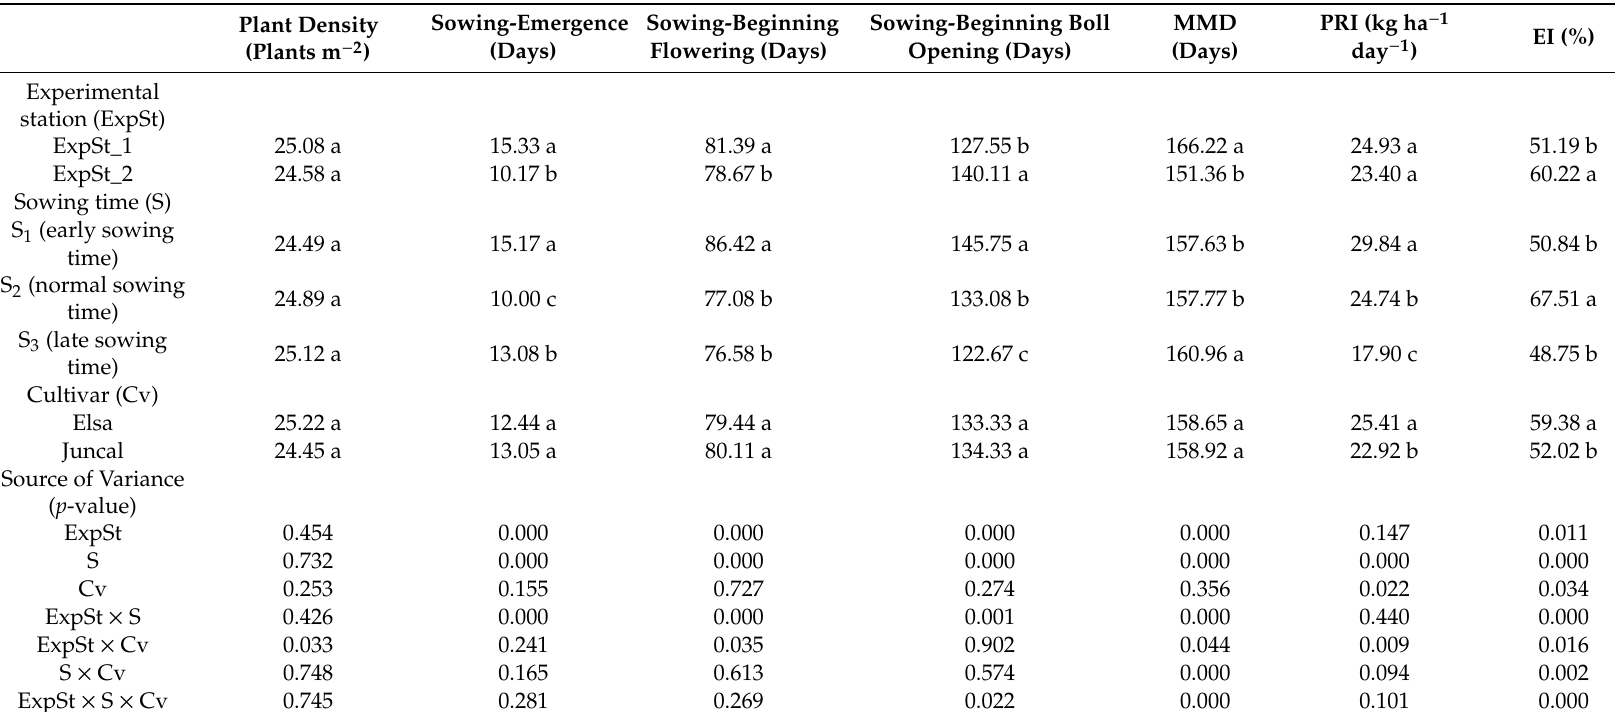
Table 5. Cotton plant phenology and earliness derived from di ff erent experimental stations, sowing times and cultivars during the year 2012. Plant